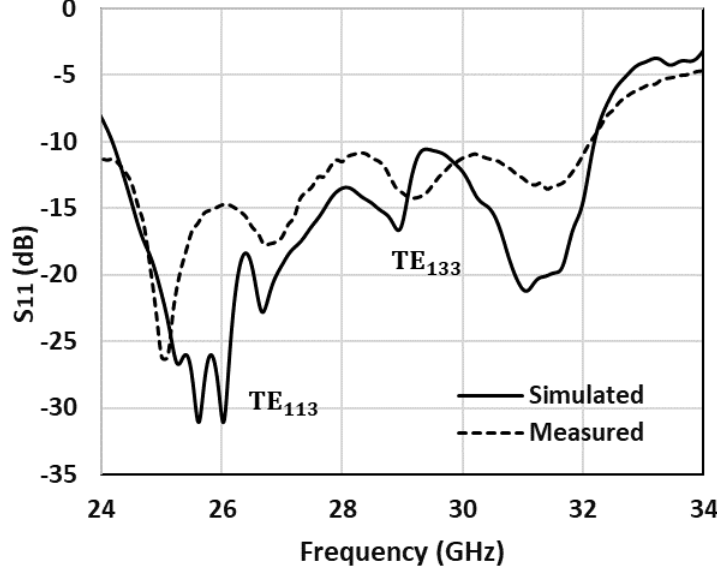
Figure 18. The simulated and measured |S 11 | of the DRA array.